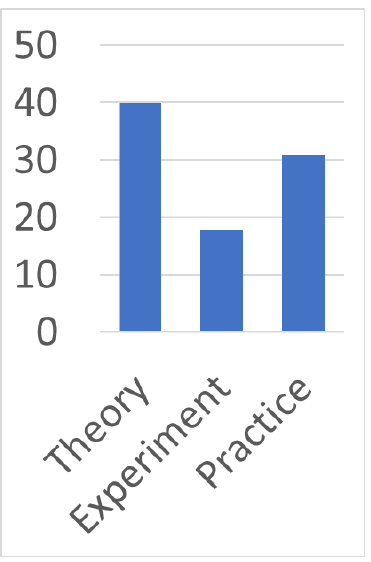
Figure 4. Distribution of publications by